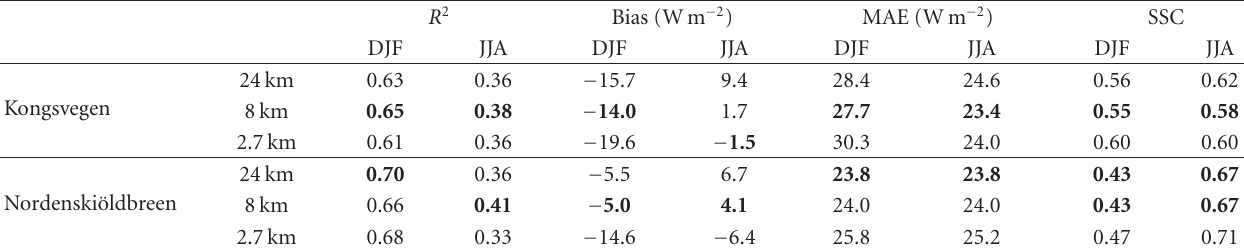
Table 7: Statistical evaluation of incoming long-wave radiation in winter and summer 2009-2010. Bold numbers indicate the best result for each AWS. Vestfonna data are not used here because of the lack of data during the chosen period.